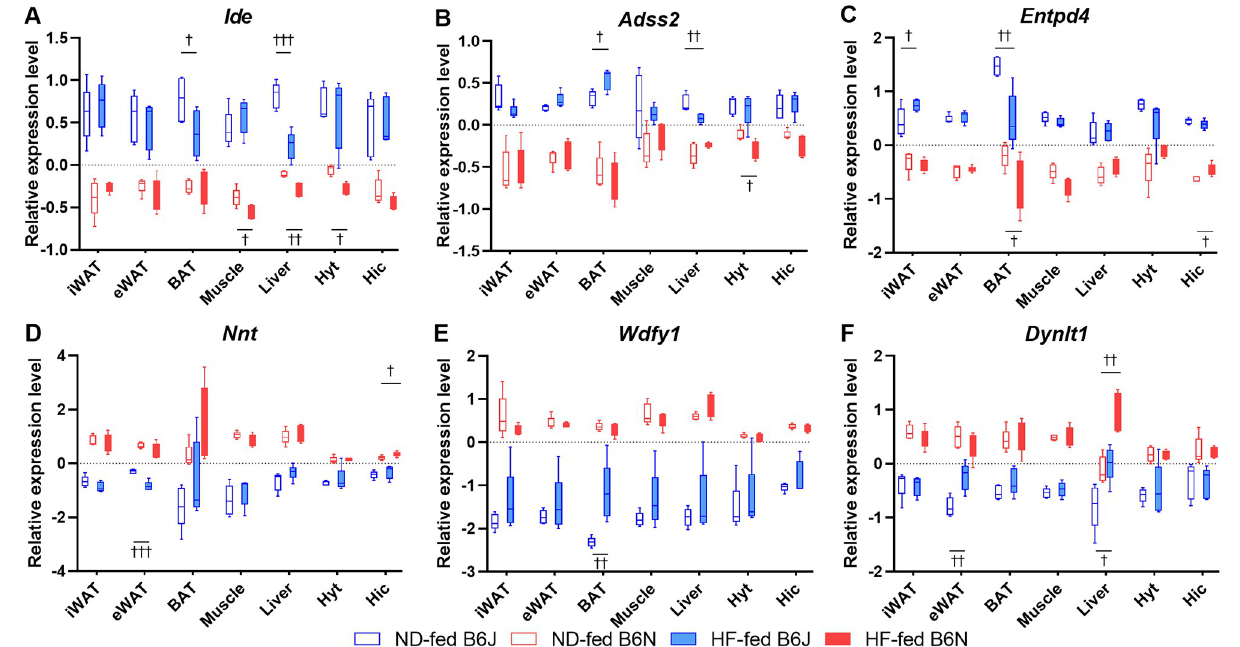
Fig 6. Expression levels of DEGs between B6J and B6N on ND or HF. The gene name is indicated at the top of each plot, and the y-axis represents the normalized signal values. (A) Ide , insulin degrading enzyme; (B) Adss2 , adenylosuccinate synthase 2; (C) Entpd4 , ectonucleotide triphosphate diphosphohydrolase 4; (D) Nnt , nicotinamide nucleotide transhydrogenase; (E) Wdfy1 , WD repeat and FYVE domain containing 1; (F) Dynlt1 , dynein light chain Tctex-type1. Boxes are representative of means ± SEM (n = 5) for the B6J (blue color) and B6N (red color) groups. Three-way ANOVA (Df = 110 for all analysis) indicated a significant interaction between substrain, diet, and tissue for Adss2 ( p < 0.05; F = 2.59) and Entpd4 ( p < 0.01; F = 3.24); a significant interaction between substrain and diet for Wdfy1 ( p < 0.001; F = 13.96); a significant interaction between diet and tissue for Ide ( p < 0.05; F = 2.71), Entpd4 ( p < 0.0001; F = 10.38), Nnt ( p < 0.001; F = 4.32), and Dynlt1 ( p < 0.0001; F = 9.51) and a significant interaction between strain and tissue for Adss2 ( p < 0.0001; F = 10.90), Entpd4 ( p < 0.0001; F = 5.49), Nnt ( p < 0.0001; F = 6.75), Wdfy1 ( p < 0.001; F = 4.34), and Dynlt1 ( p < 0.05; F = 2.24). There was a significant effect of strain on Ide , Adss2 , Entpd4 , Nnt , Wdfy1 , and Dynlt1 ( p < 0.0001; F = 554, 453, 723, 289, 821, and 406, respectively) independent of diet and tissue, and a significant effect of diet on Ide ( p < 0.01; F = 10.40), Entpd4 ( p < 0.05; F = 6.56), Wdfy1 ( p < 0.01; F = 8.73), and Dynlt1 ( p < 0.0001; F = 17.78) independent of strain and tissue. There was a significant effect of tissue on Ide ( p < 0.05; F = 2.39), Adss2 ( p < 0.05; F = 2.53), Entpd4 ( p < 0.0001; F = 8.65), Nnt ( p < 0.05; F = 2.31), Wdfy1 ( p < 0.05; F = 2.54), and Dynlt1 ( p < 0.05; F = 2.21) independent of strain and diet. Daggers (†) indicate significant differences between ND and HF groups ( † p < 0.05, †† p < 0.01, and ††† p < 0.001, Tukey’s post hoc test). ND, normal diet; HF, high-fat diet; open blue boxes, ND-fed B6J; open red boxes, ND-fed B6N; filled blue boxes, HF-fed B6J; filled red boxes, HF-fed